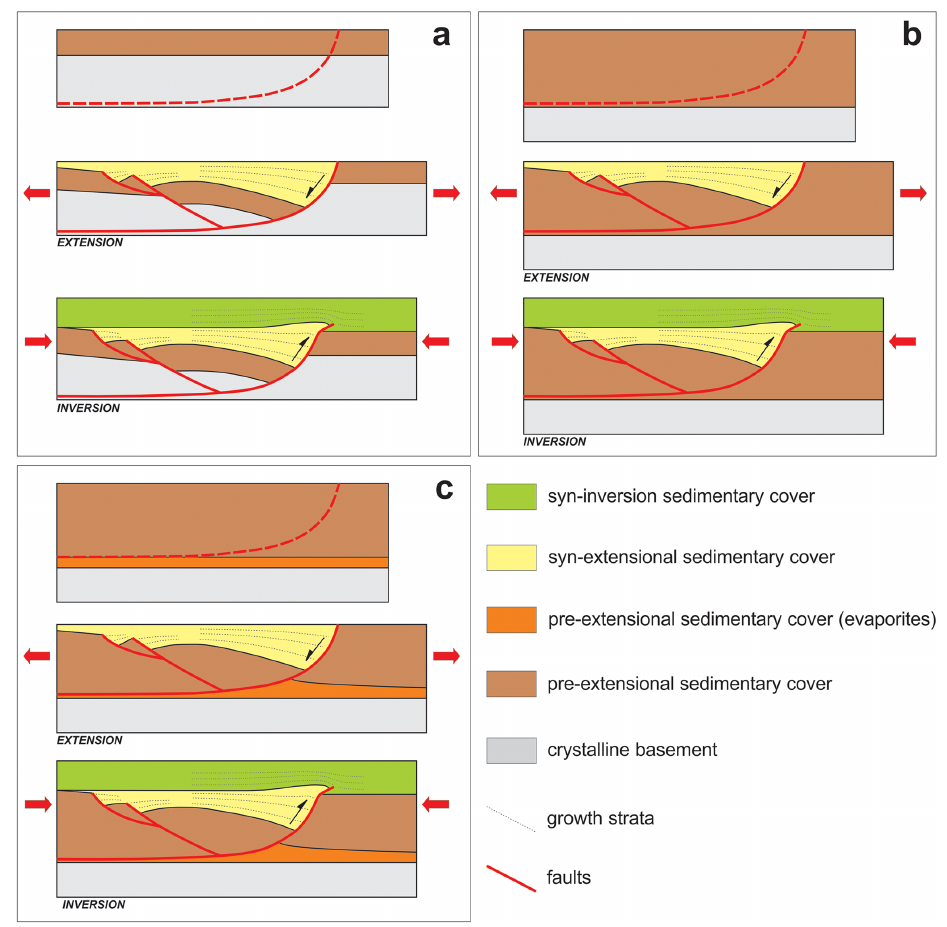
Figure 1. (a) Classic thick-skinned model of inversion of half-graben with master listric fault rooted within the crystalline basement, based on Bally (1984); see also Cooper and Warren (2010, 2020) and Tari et al. (2020). (b) Thin-skinned model of inversion of half-graben with master listric fault rooted within the thick pre-extensional sedimentary cover. (c) Thin-skinned model of inversion of half-graben with master listric fault detached above pre-extensional evaporites. Note that all three models, despite their different structural characteristics at depth, have the same shallower tectono-sedimentary expression with identical key elements of the inverted extensional system such as inversion anticline and syn-inversion growth